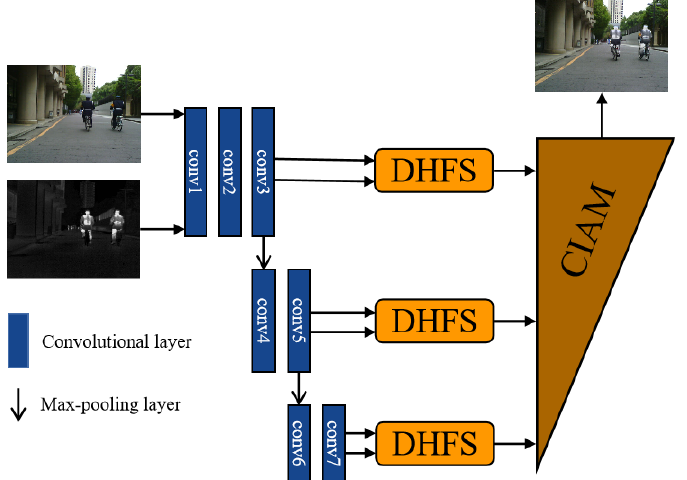
Figure 1. The proposed DCFusion network ( S vi , S ir represents source images and O indicate out- put image).